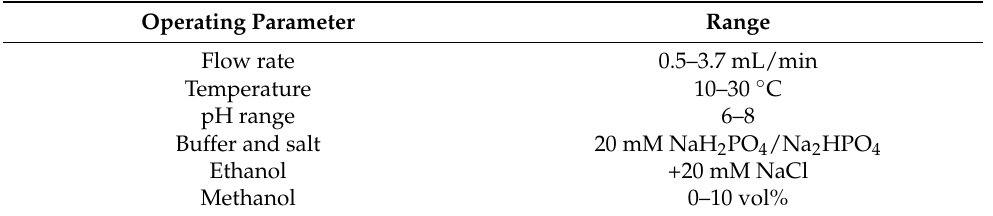
Table 7. Experimental conditions for testing the immobilized AAR.